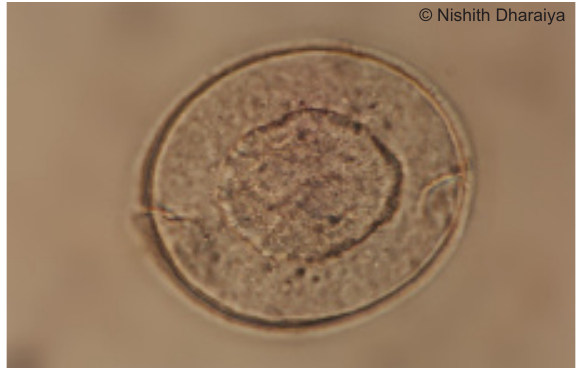
Image 12. Cross section of hair of